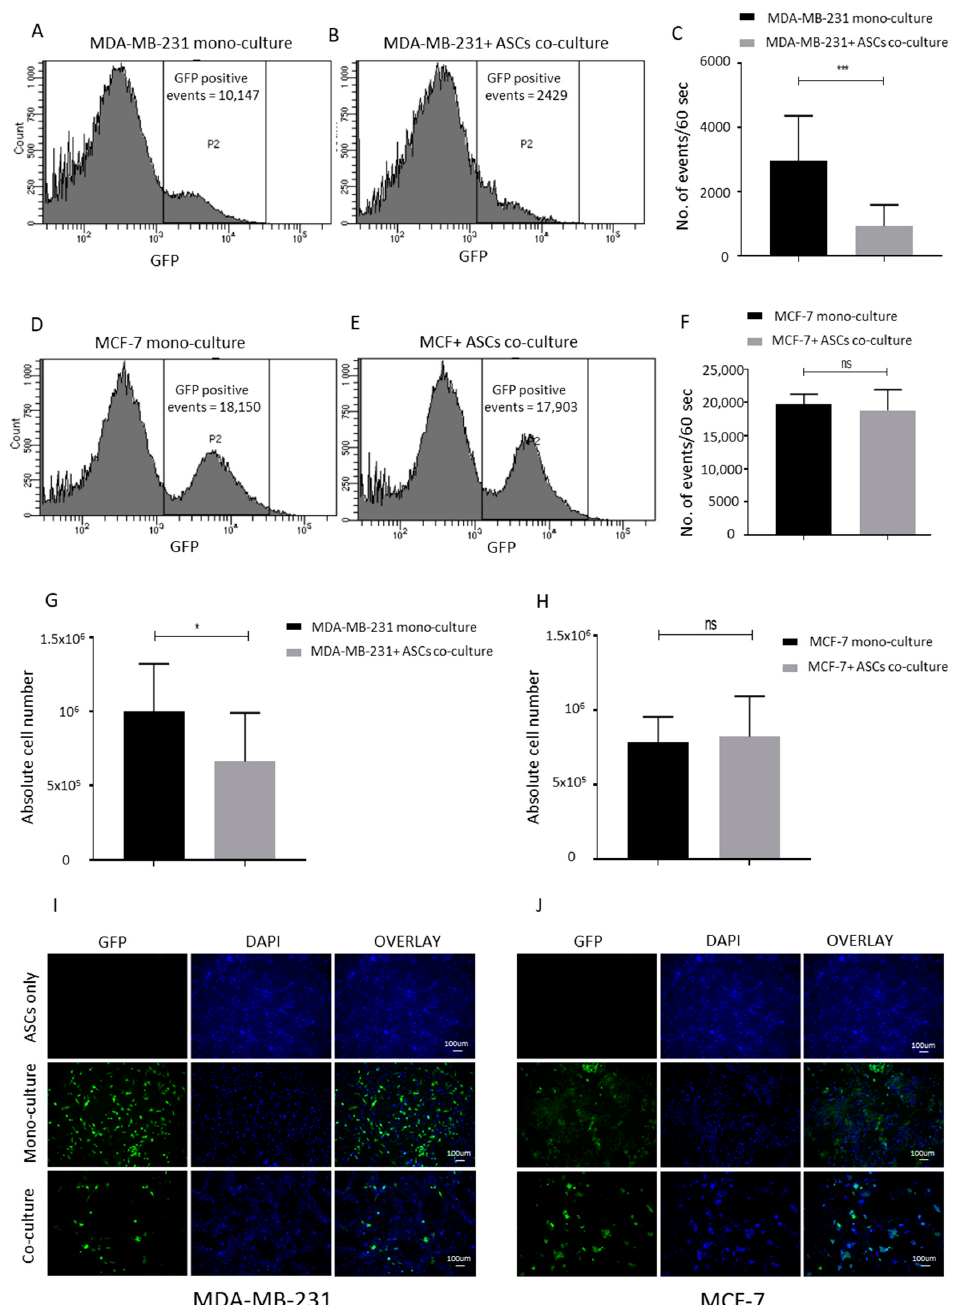
Figure 4. ASCs contact culture inhibits the proliferation of MDA-MB-231 cells. ( A – C ) Contact co-culture of MDA-MB-231 cells with ASCs. MDA-MB-231 expressing GFP were seeded either alone ( A ) or on confluent ASCs ( B ) for 4 days. The numbers of GFP-positive events per minute were counted 4 days post culture by using flow cytometry and plotted ( C ). ( D – F ) Contact co-culture of MCF-7 cells with ASCs. MCF-7 cells expressing GFP were seeded either alone ( D ) or on confluent ASCs ( E ) for 4 days. The numbers of GFP positive events per minute were counted 4 days post culture by using flow cytometry, and plotted ( F ). The graphs are representative of 3 independent experiments using ASCs from di ff erent donors. ( G , H ) Absolute number of cells counted by Neubauer chamber from the experimental settings ( A , B ) shown in ( G ) and from ( D , E ) as reflected in ( H ). ( I , J ) Fluorescent microscope images of MDA-MB-231 / ASCs co-culture ( I ) and MCF-7 / ASCs co-culture ( J ) are shown. GFP-positive cells are green while nuclear stain DAPI stain blue. p value < 0.05 = *, p < 0.001 = ***, ns =